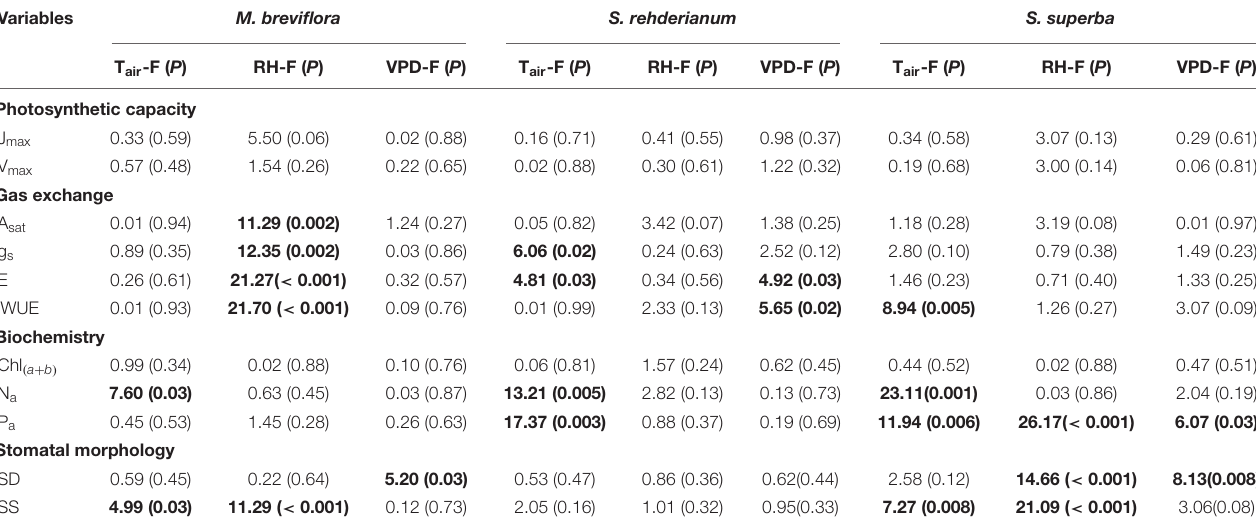
TABLE 4 | Summary report of effects of air temperature (T air , ◦ C), air moisture (RH,%) and vapor pressure difference (VPD, kPa) on photosynthetic capacity, gas exchange, biochemistry and stomatal morphology for Machilus breviflora , Syzygium rehderianum, and Schima superba in last 2 or 3 years under infrared warming by the mixed liner